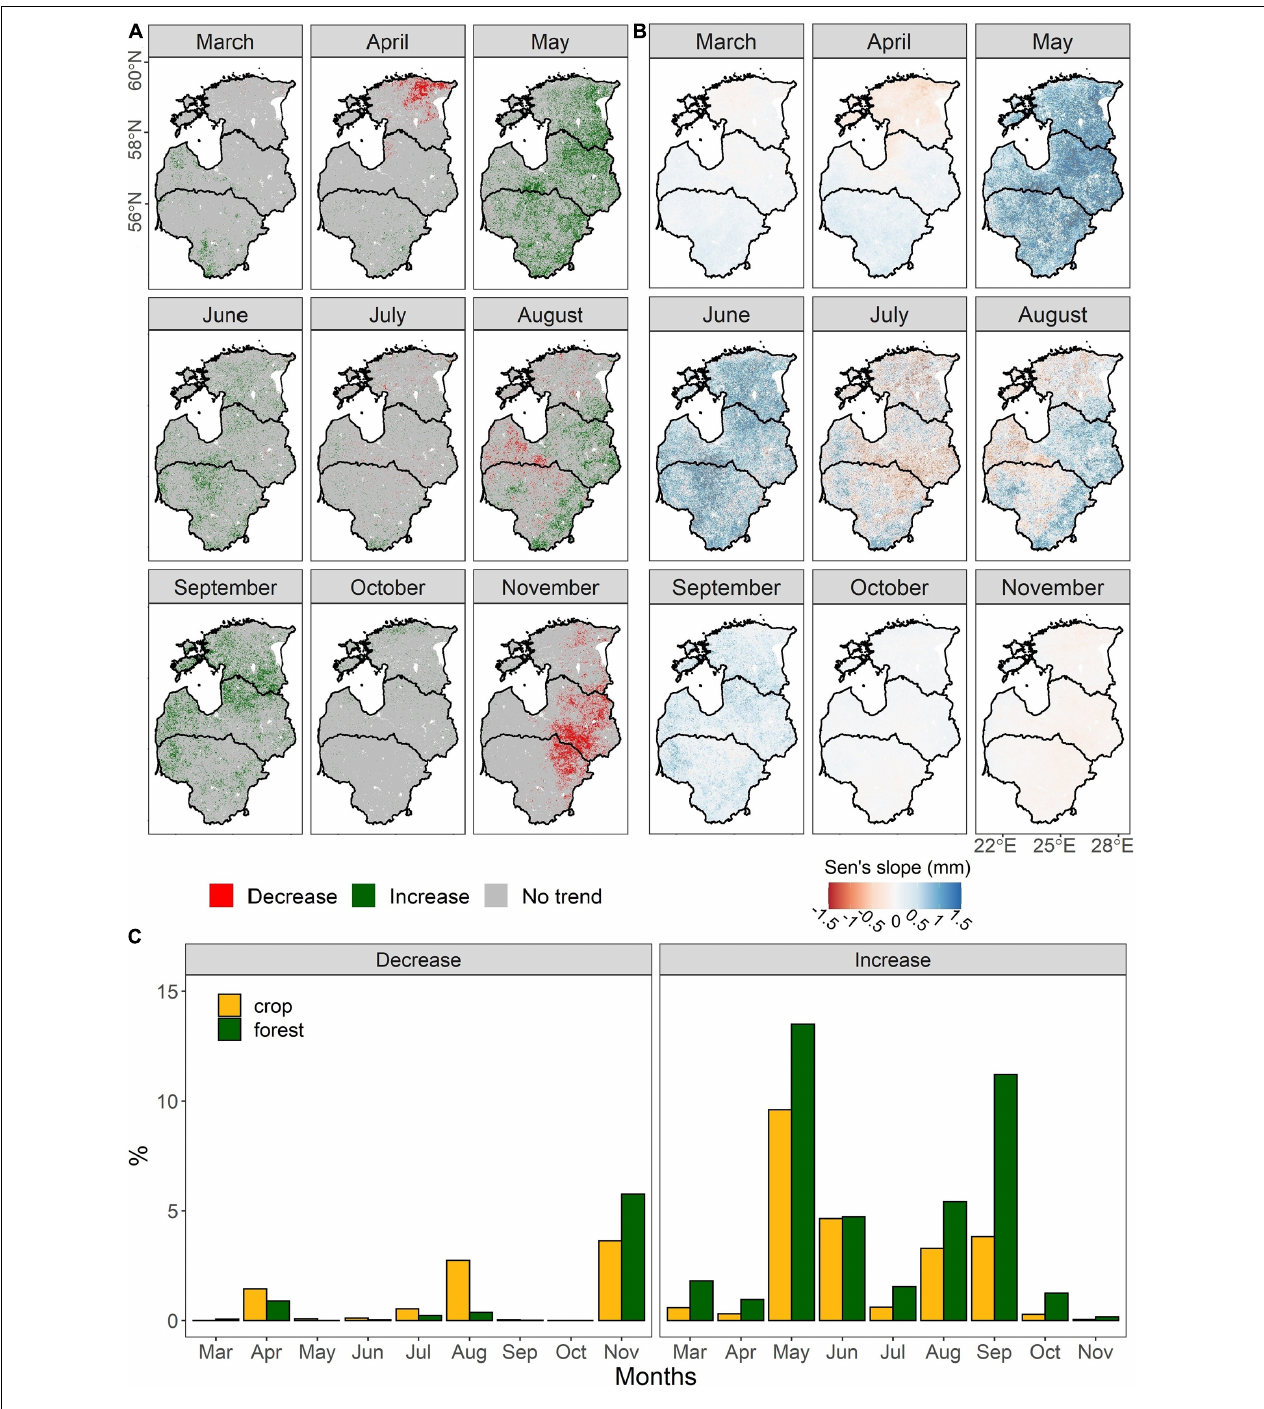
FIGURE 4 | (A) Mann-Kendall trend analysis for evapotranspiration at a pixel scale for each month, with p < 0.05 for significant trends. (B) Sen’s slope values for evapotranspiration in each month. Positive values represent an increase, and negative values a decrease. (C) Percentage of forest and cropland pixels ( > 50% of the MODIS ET pixel area) that showed decreasing and increasing trends in each